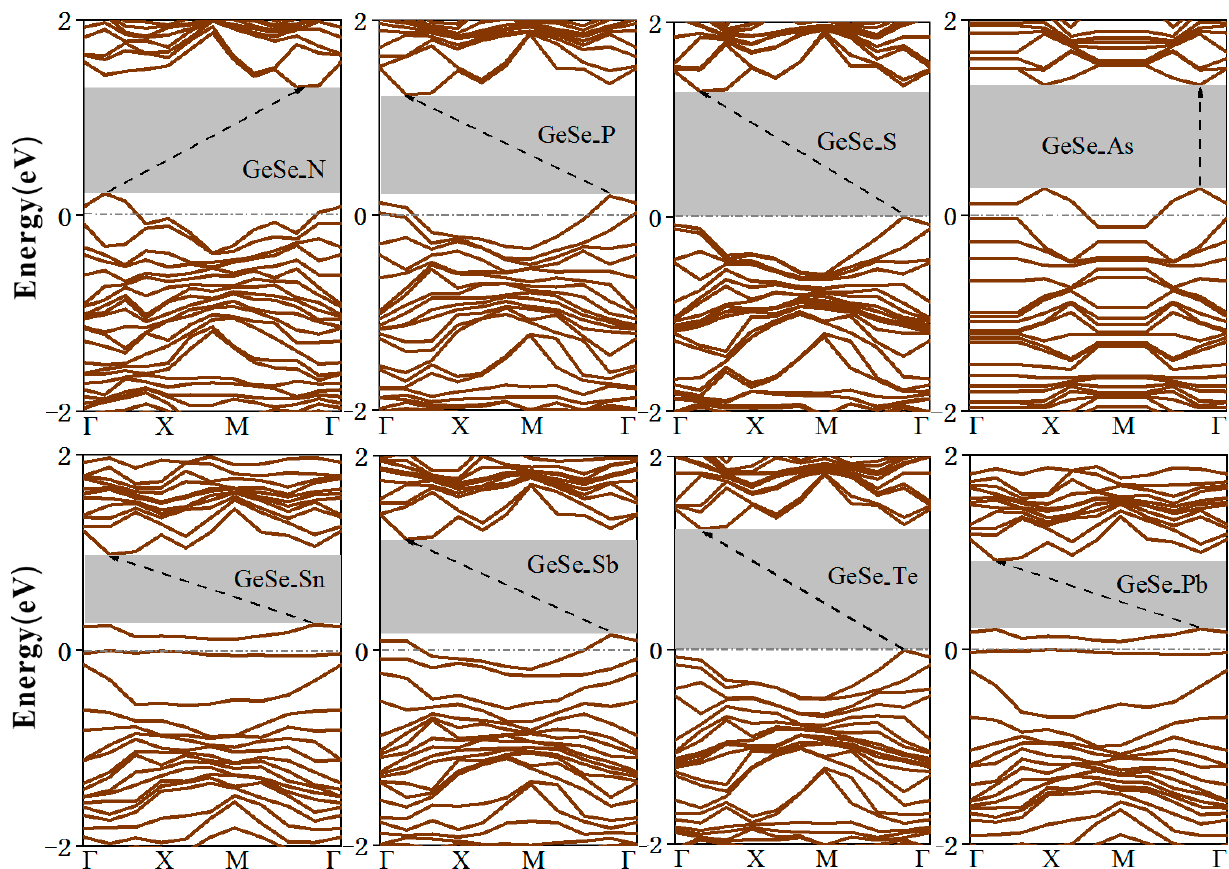
Figure 4. Electronic band structure of the doped model (GeSe_N, GeSe_P, GeSe_S, GeSe_As, GeSe_Sn, GeSe_Sb, GeSe_Te, and GeSe_Pb) for the most stable structures. The shaded region indicates the bandgap, and the dashed lines indicate the bandgap type.